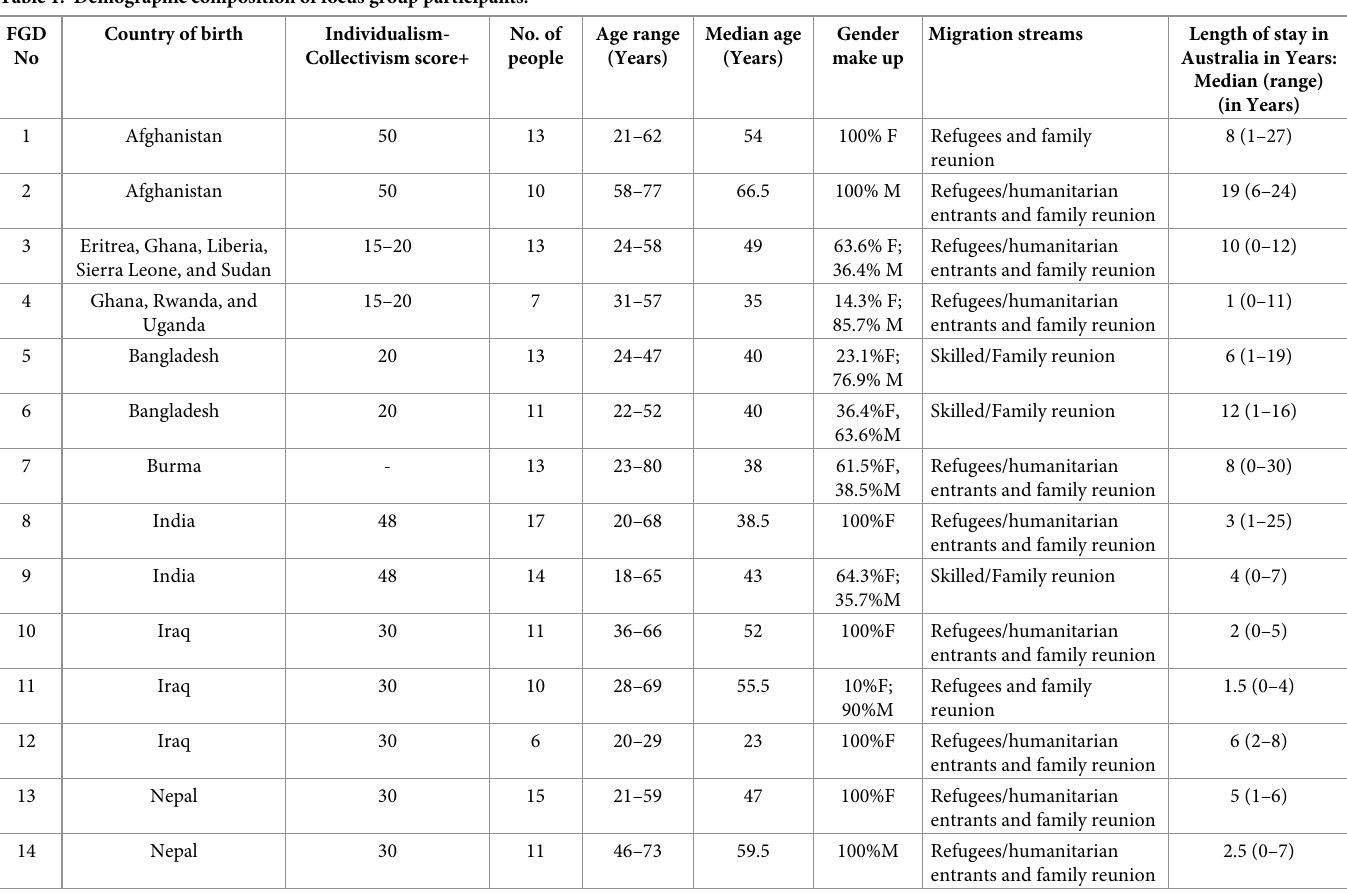
Table 1. Demographic composition of focus group